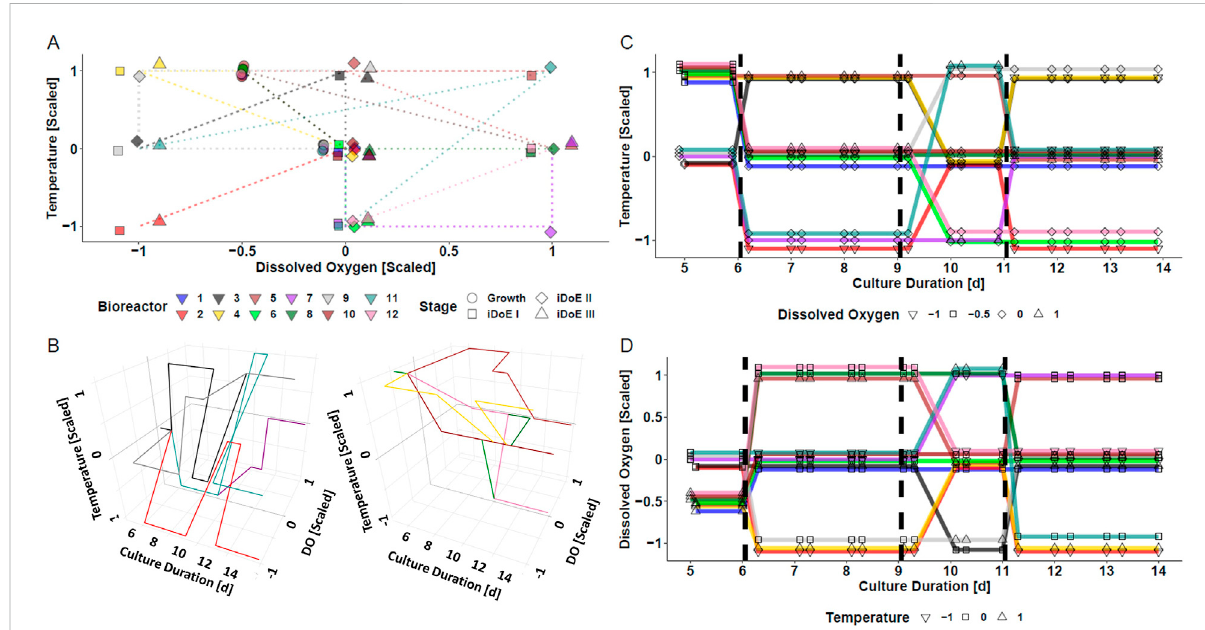
FIGURE 1 Visualization of the Conducted iDoE for the Investigation of the Effect of the Input Parameters Temperature and DO Over Time During the Production Phase of a Mammalian Cell Culture Process. (A) Coverage of the design space de fi ned by temperature and DO by the varying input parameter setpoints applied to the bioreactors over the course of the four experimental stages. Only one replicate per stage is depicted, while there were7,7,3,and6samplingtimepointsinthegrowthphase,iDoEstageI,II,andIII,respectively. (B) Visualizationofthedesignspacecoveragein three dimensions for bioreactors operated at platform (left) or optimized (right) growth settings. Changes of the input parameter setpoints of temperature (C) and DO (D) during day fi ve and harvest are visualized with a jitter in the y -axis and diagonal connections instead of vertical steps to avoid overlay of the